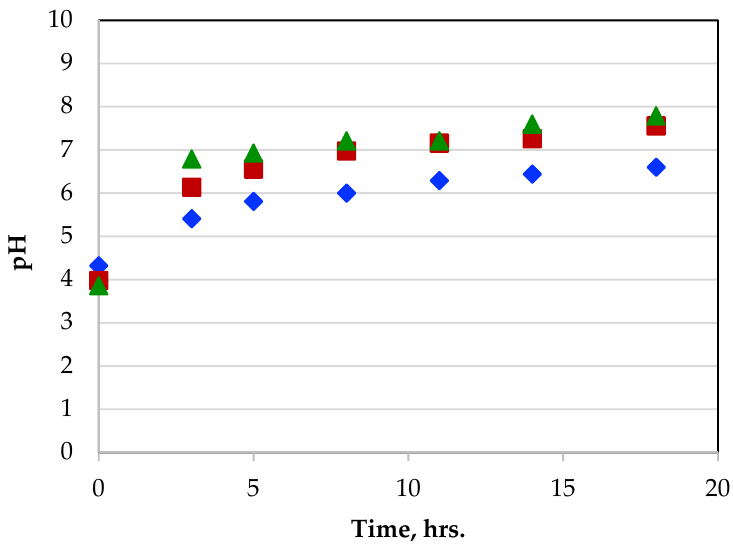
Figure 9. Effect of contact time on the pH of solutions during adsorption of Cu(II) ( ◆ ), Pb(II) ( ◼ ) and Cd(II) ( ▲ ) by hybrid monoliths GS 2:1: initial Cu(II) concentration 10 ppm, mass of adsorbent monoliths 0.32 ± 0.02 g, initial pH 4 and temperature 23 ± 1 °C.